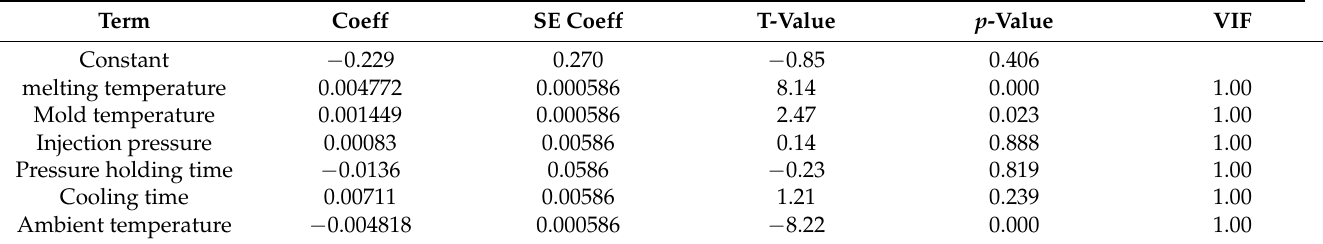
Table 5. Coefficient Table for Regression Analysis.